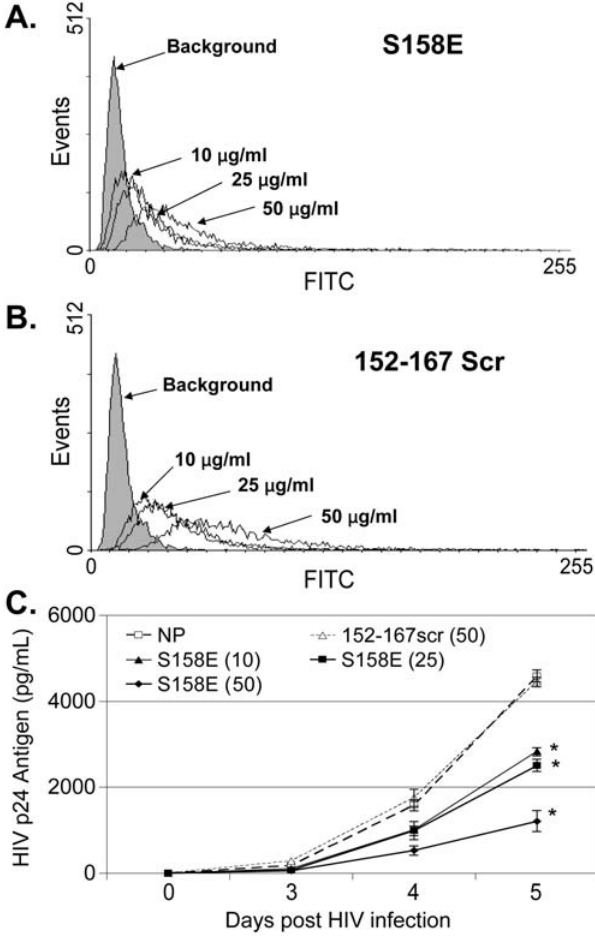
Figure 9. Dose dependent inhibition of HIV replication by the S158E mutant. MT-2 cells were incubated with three concentrations (10, 25, and 50 m g/ml) of synthetic peptides containing GBV-C S158E (A) or 152–167scr (B) amino acid sequences in which an N-terminal Tat- protein transduction domain was included, and the peptides were conjugated to FITC. Cells were washed one hour later and FITC was monitored by flow cytometry. Cells were infected with HIV 24 hrs after incubation, and dose related inhibition of HIV replication was observed for the S158E peptide, but not the 152–167scr peptide compared to the no peptide control (NP). * HIV p24 antigen area under the curve was less than controls (p , 0.01).